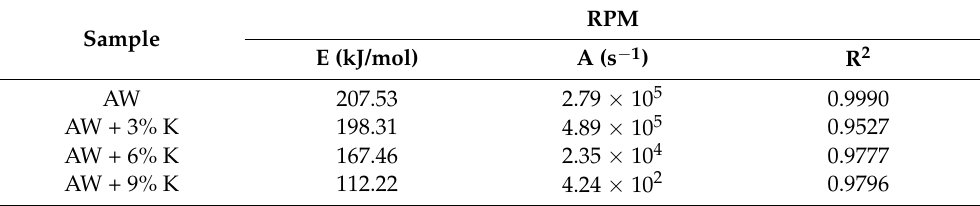
Figure 5. Arrhenius plot of RPM model for coal char with different KCl concentration. Table 4. Summary of the kinetic and empirical parameters of the RPM model.